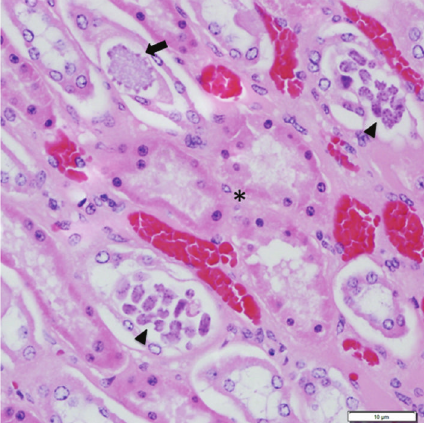
Figure 2: Multiple stages of Klossiella equi are found multifocally expanding tubular epithelial cells (schizont, arrow; sporocysts, ar- rowheads). Occasional tubular necrosis is present (asterick).